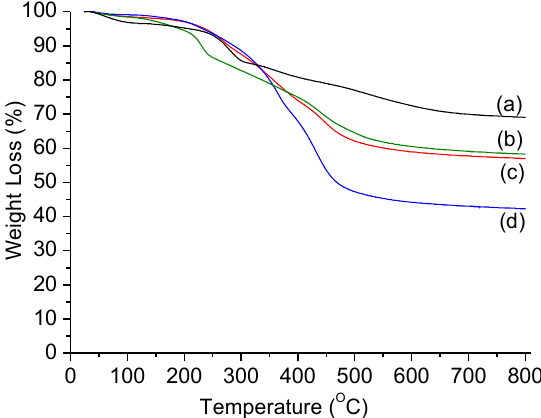
Figure 3. Thermogravimetric analysis (TGA) of the modified silica nanoparticles: ( a ) MSN-Br, ( b ) MSN-PDEAEMA, ( c ) MSN-PDEAEMA-Cys, and ( d ) MSN-PDEAEMA-Cys-POEGMEMA.